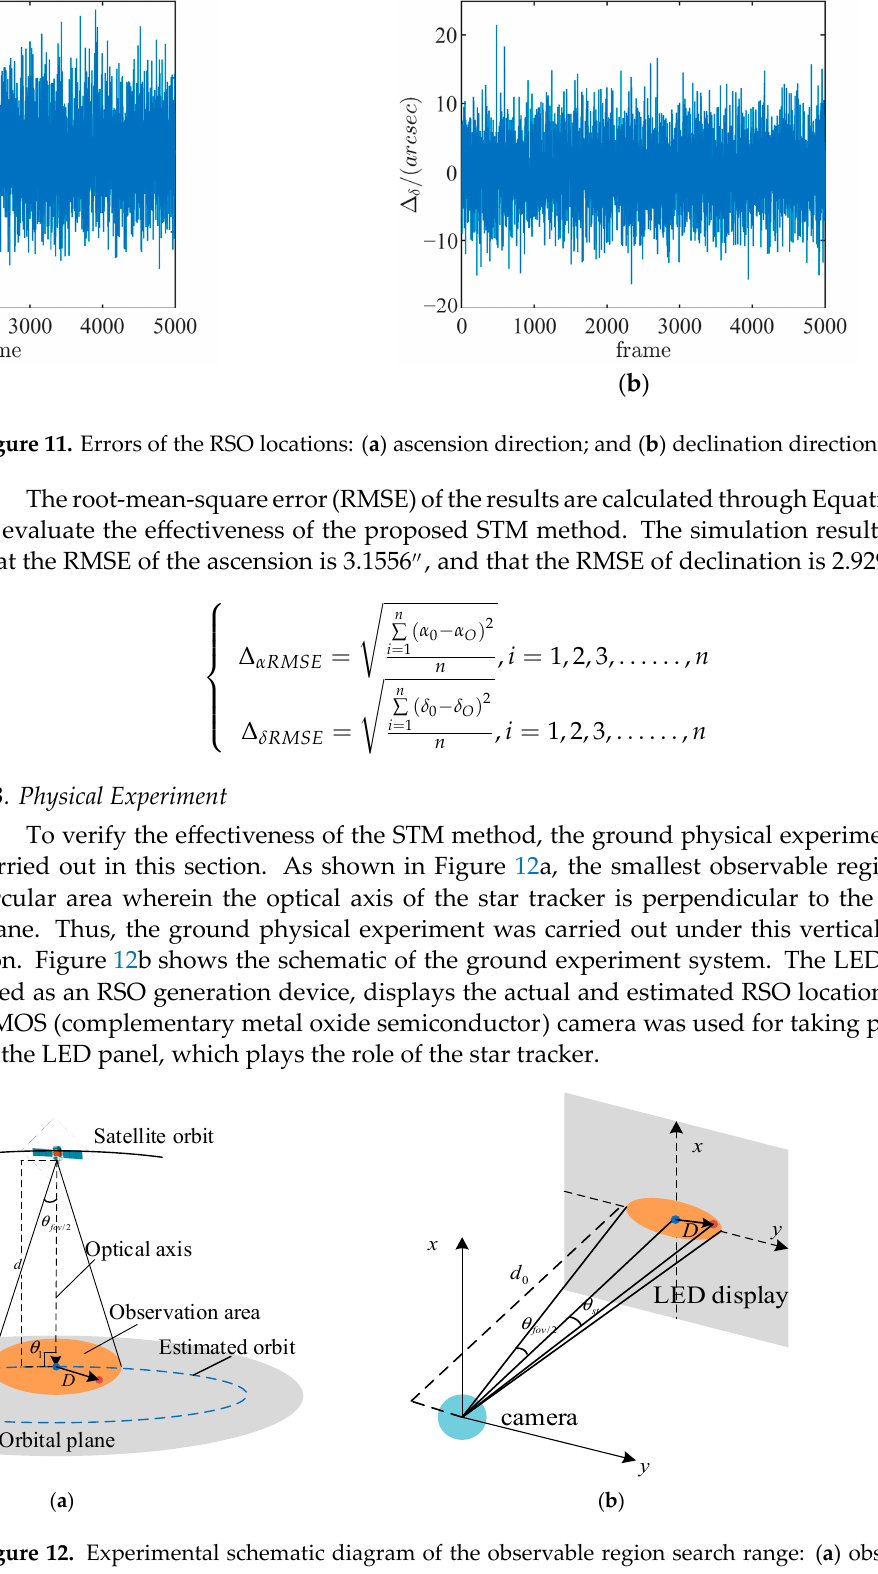
Figure 12. Experimental schematic diagram of the observable region search range: ( a ) observable region; and ( b ) schematic of the ground experiment system. The principle of the physical experiment system for the STM method validation is geometric scaling. This means that the parameters on the ground experiment system and the on-orbit parameters are scaled at 1:10 7 . The parameters of the experimental system are listed in Table 4. The object distance between the camera and the LED panel is 60 cm, which means that the actual distance between the star tracker and the RSO is 6000 km according to the scale bar. Additionally, the ground experiment system is shown in Figure 13. To achieve sub-pixel centroid algorithm accuracy, the 3 × 3 pixel-matrix is used to complete the display of the RSO, as shown in Figure 13. The two centroids of the pixel- matrix represent the actual and estimated RSO positions. Table 4. Ground experiment parameters. Serial Number